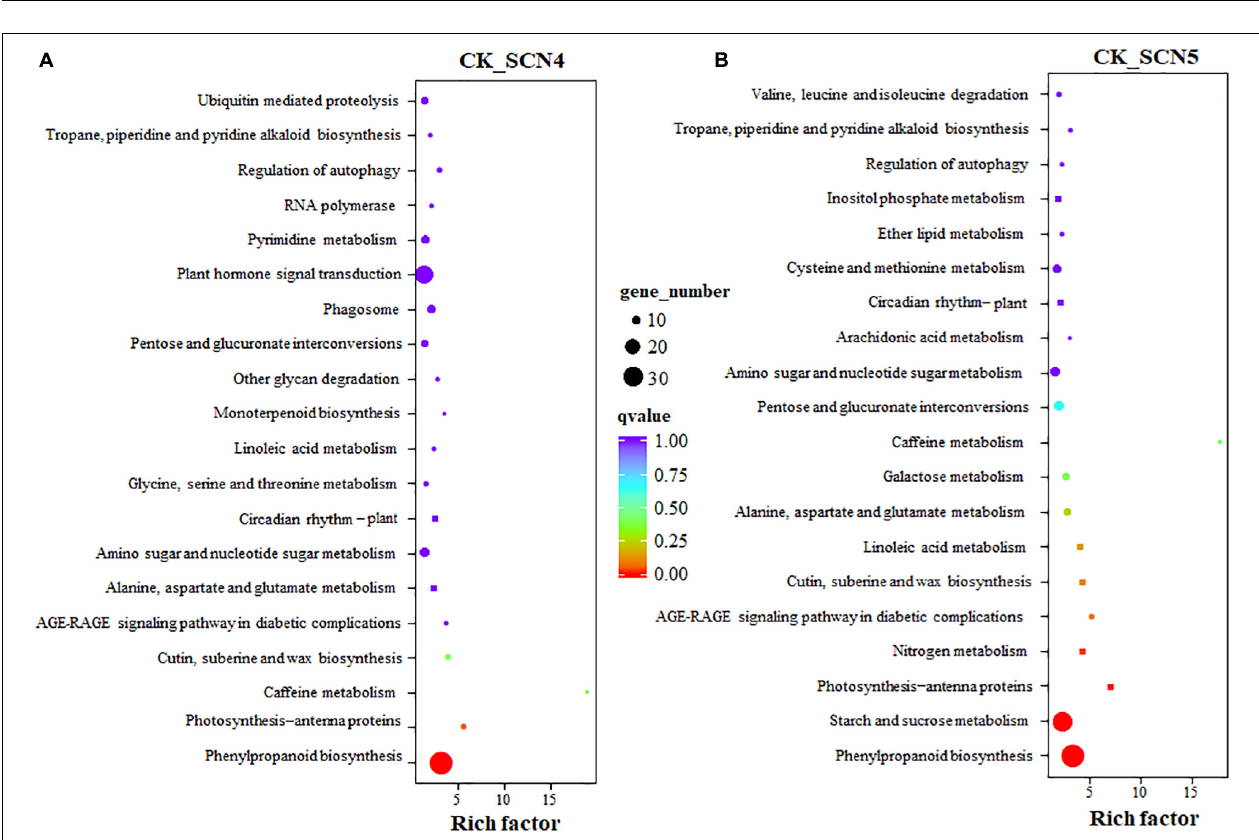
FIGURE 6 | (A,B) KEGG pathway enrichment of DEGs (differentially expressed genes) in soybean treated with soybean cyst nematode race 4 (SCN4) and race 5 (SCN5) when compared with the control. Each circle represents one KEGG path, the ordinate axis represents the path name, and the horizontal axis is enrichment factor. Circle size suggests the number of enriched DEGs in the pathway, the larger the circle, the more DEGs.